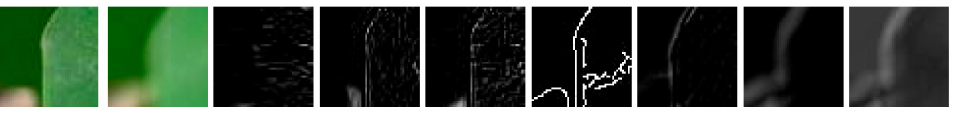
Figure 2. Image edges comparison of blurred image (from left to right are clear image, blurred image, horizontal first-order gradients, vertical first-order gradients, second-order gradients, edges extracted by Canny operator, Laplace gradients, local edges of gray image, and local edges of color